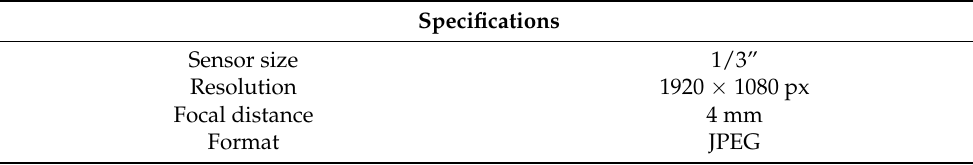
Table 1. RGB dual sensor